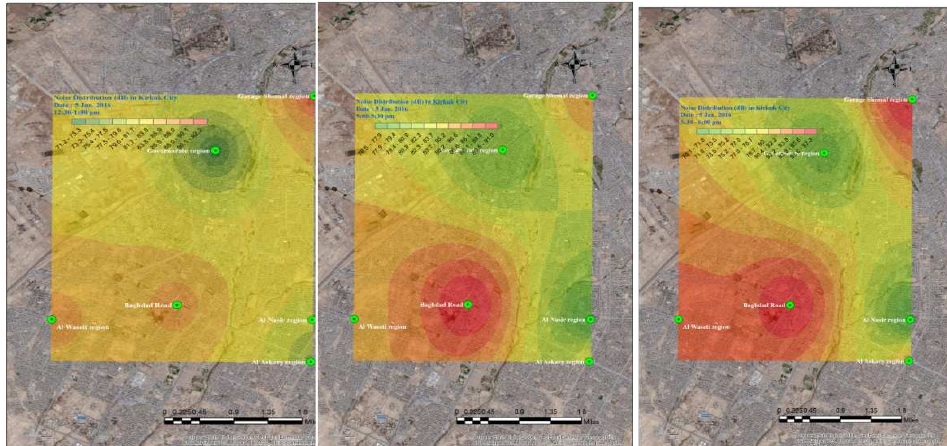
Fig. 5. Hourly Noise Distribution for the peak morning and evening traffic flow 5 Jan. 2015 Kirkuk City.